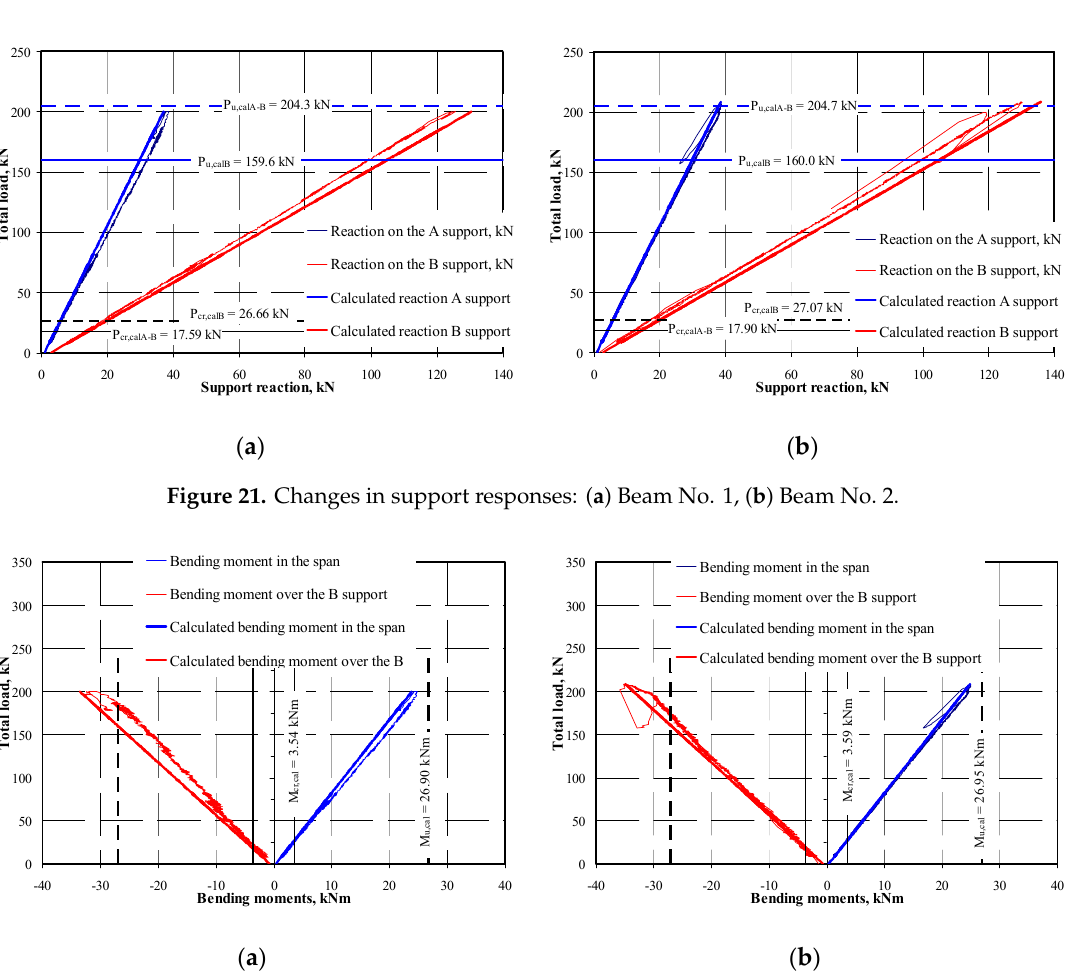
( b ) Figure 20. Rotations of bottom sections at the time of failure: ( a ) Beam No. 1, ( b ) Beam No. 2. 5. Discussion Figure 21 shows the comparison of changes in support responses that were experimentally determined or calculated from the model of an elastic continuous beam. There was no significant difference in measured and theoretical responses until cracking of the support section. At that time a small drop in response values was observed for the internal support B at simultaneously increasing response at the edge support A. A further increase in loads clearly reduced the response mechanism of the internal support and caused an increase in the response from the edge support. However, these changes were nearly proportional. At the time preceding the failure, the values of measured and calculated responses differed by no more than 10% with reference to theoretical responses. Figure 22 shows changes in bending moments in the over-support and span sections where the